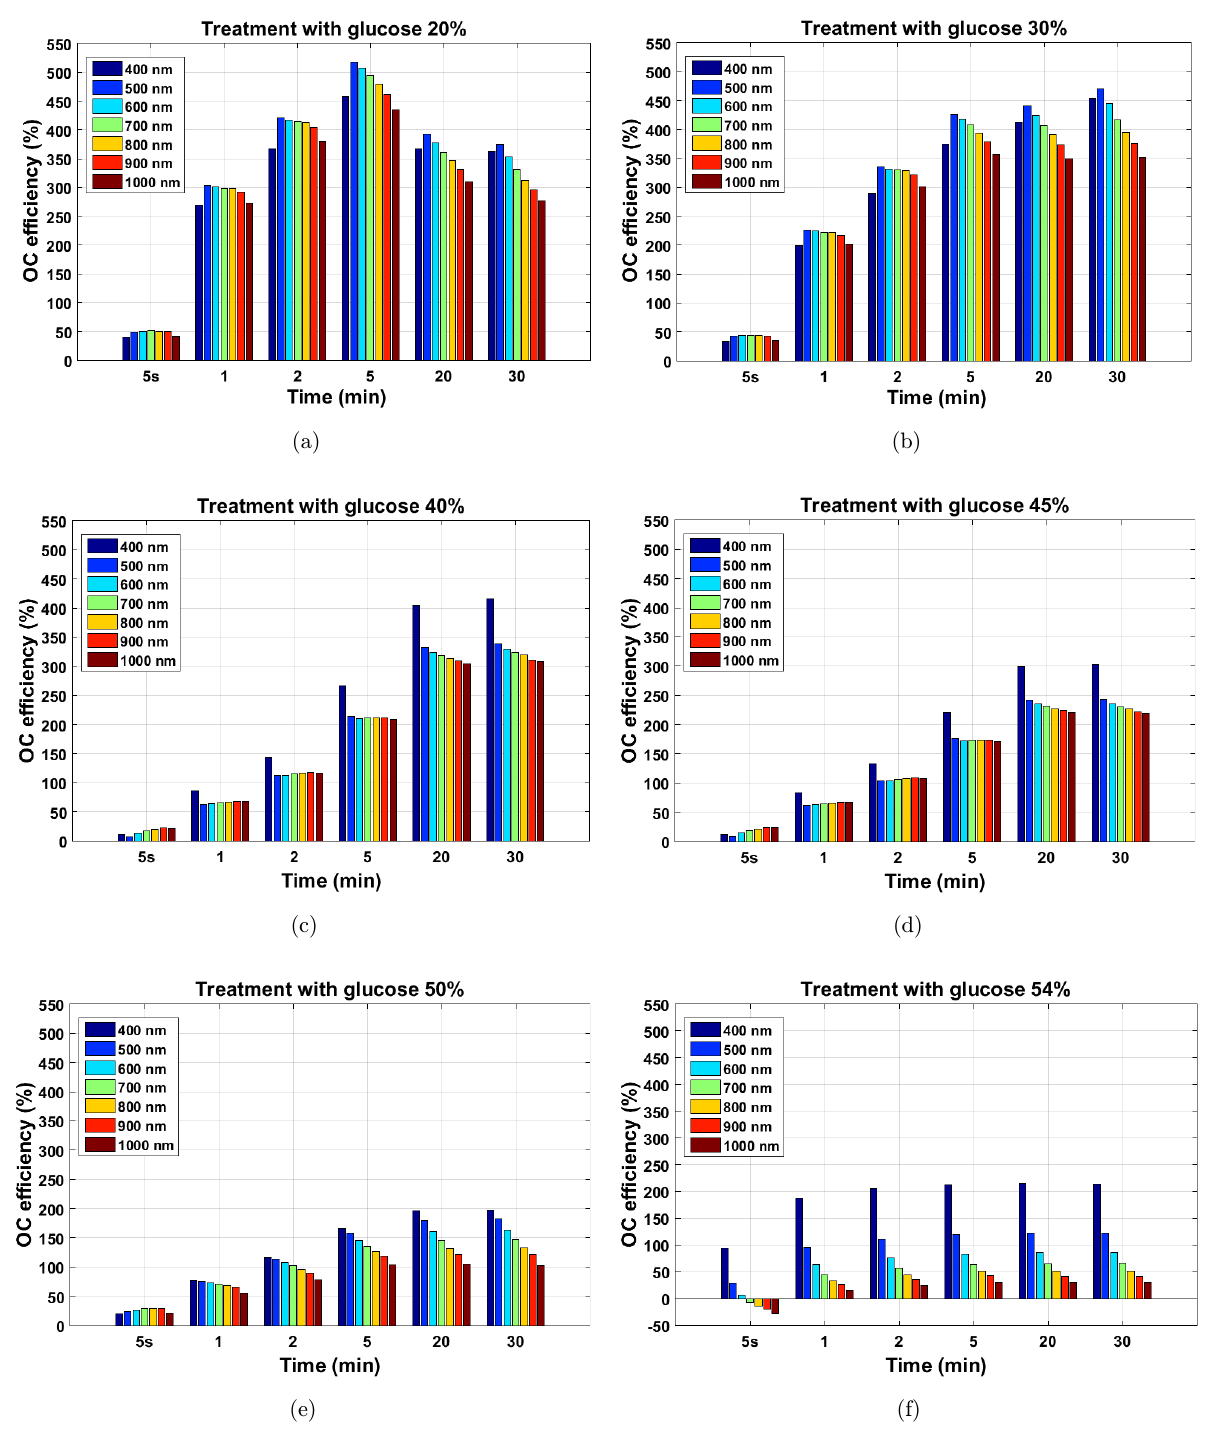
Fig. 5. OC e±ciency for the treatments with glucose: 20% (a), 30% (b), 40% (c), 45% (d), 50% (e), and 54%